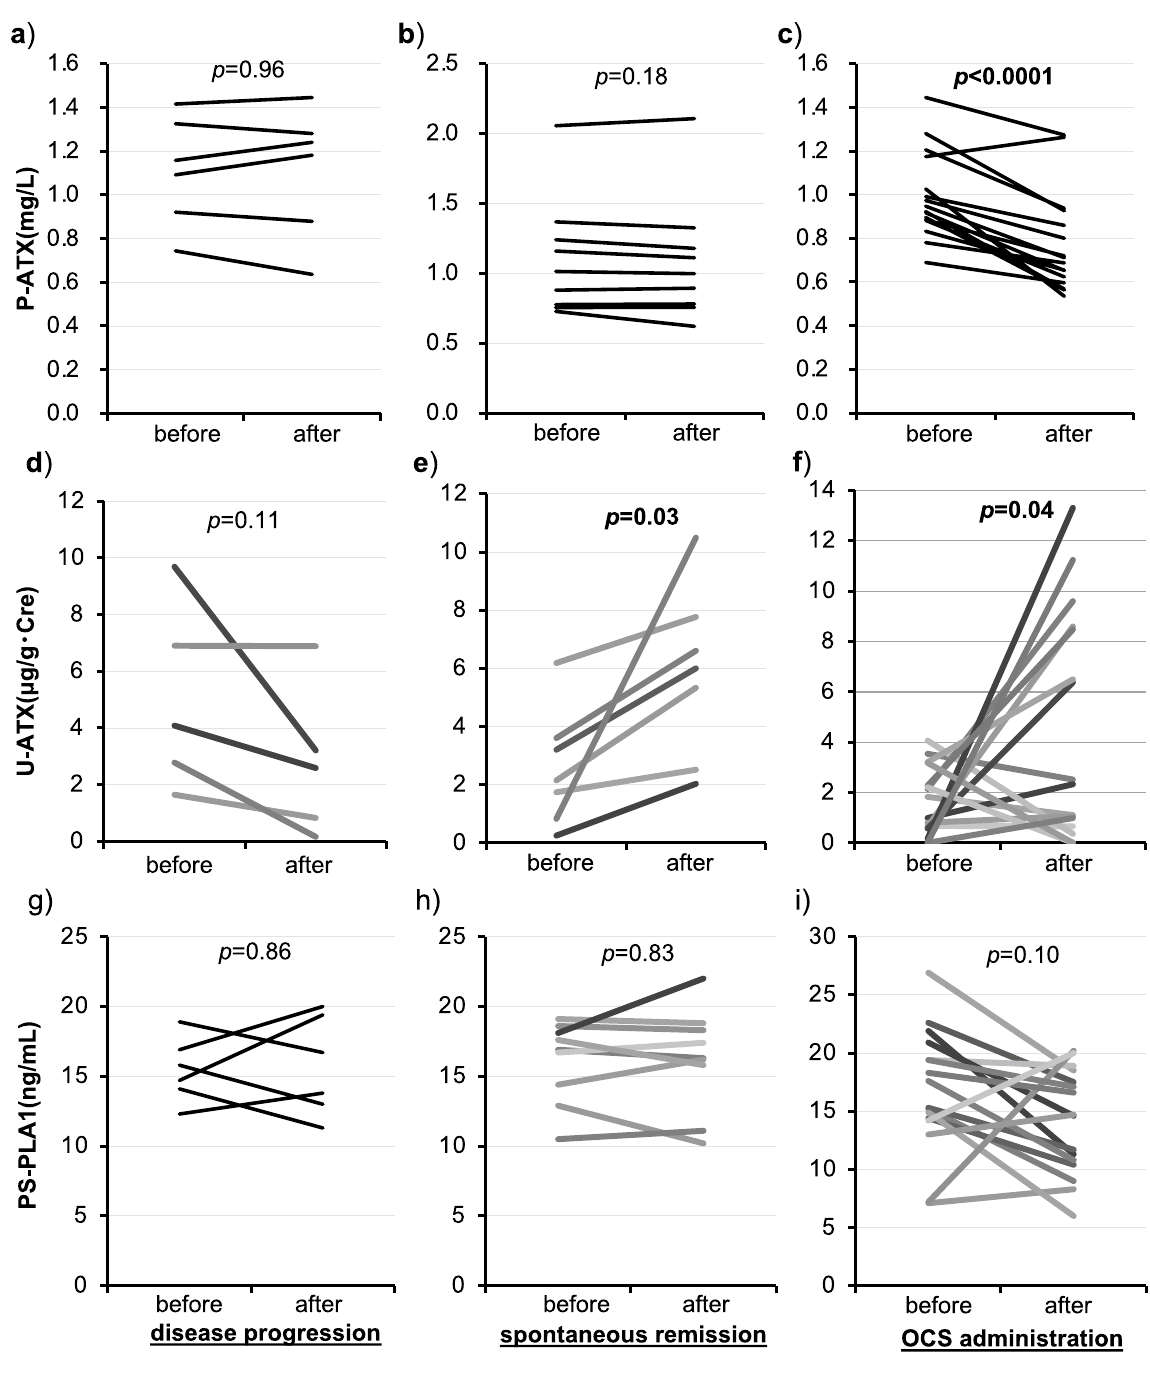
in paired-samples from the same patients with modification in their clinical status such as disease progression ( a , d , g ), spontaneous remission ( b , e , h ) and OCS administration ( c , f , i ). Data were analyzed by paired t-test. Bold denotes values p <